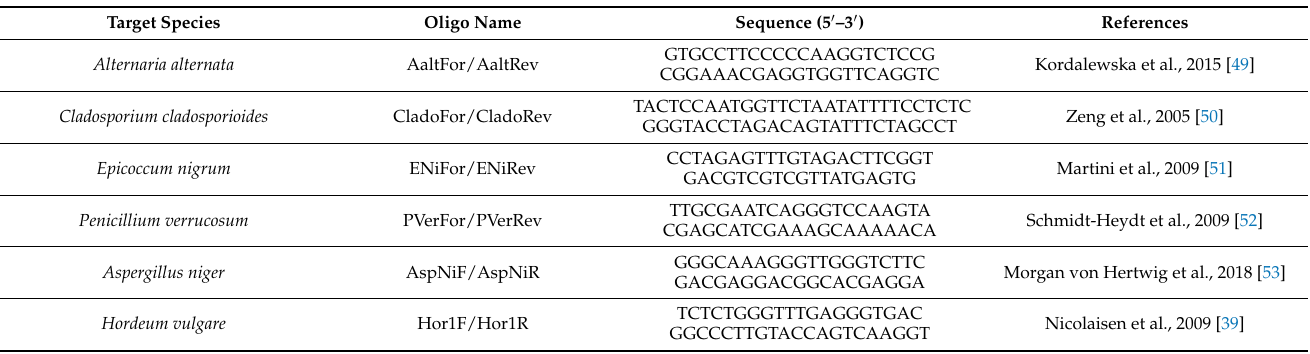
Table 1. Oligonucleotides used for the detection and quantification of the fungi of interest in barley and barley malt kernels via qPCR